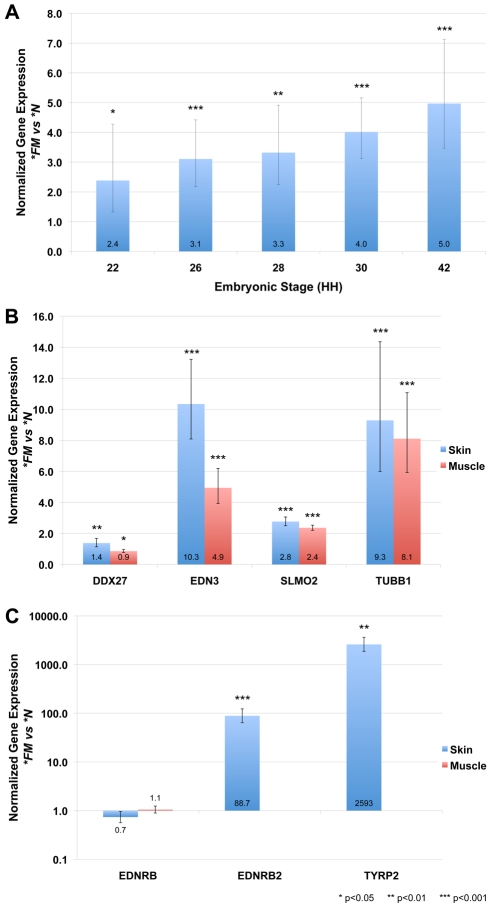
Genomic rearrangement drives increased expression of genes located within the duplicated region in FM embryonic and adult tissues.Gene expression analysis by SYBR Green qPCR of *FM (Silkie breed) tissue normalized to the *N (New Hampshire breed) and calibrated to glyceraldehyde 3-phosphate dehydrogenase (GAPDH). Error bars indicate 95% confidence intervals and significance thresholds are indicated. (A) Embryo tissue cross sections were collected at the level of the wing bud at the indicated stages. EDN3 is upregulated at all developmental stages assayed, with an increasing magnitude of differential expression in *FM tissue with age. (B) Genes located within the first duplicated region (EDN3, SLMO2 and TUBB1) are significantly increased in expression in adult skin and muscle tissue of *FM chickens. The expression of DDX27, located adjacent to but outside of the duplicated region, is also significantly differentially expressed, but does not show the same degree of upregulation as the genes within the duplication. (C) The expression of the EDN3 receptor EDNRB is not significantly different in *FM skin or muscle tissue when compared to *N tissue. However, the expression of the EDN3 receptor EDNRB2, expressed predominately by melanocytes, is highly upregulated in *FM skin tissue. A key component of the melanin biosynthesis pathway, TYRP2, is also highly upregulated in *FM skin tissue. EDNRB2 and TYRP2 expression was not detected in *N muscle tissue, so no comparison can be made to *FM skin tissue.